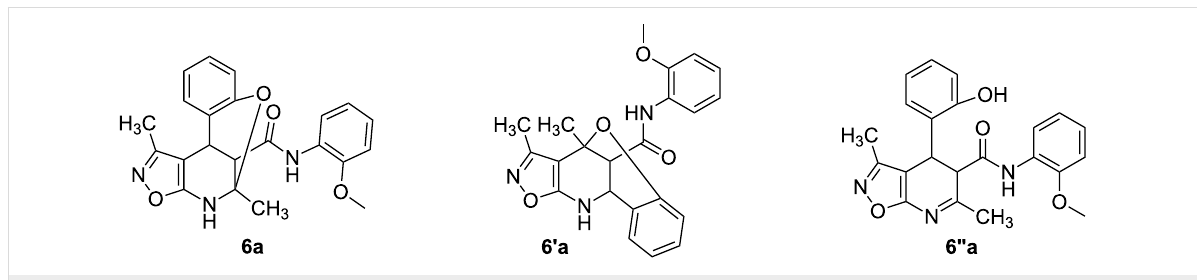
Figure 3: Alternative structures 6a , 6'a and 6''a for compound 6a .